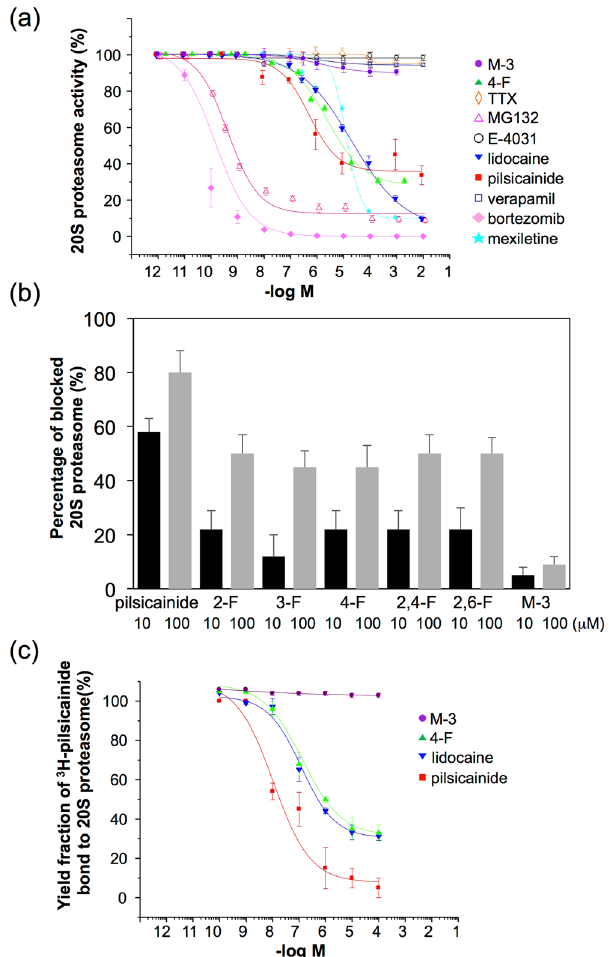
E-4031; ◊ : TTX; ▲ : 4-F; ● : M-3) on 20S proteasome activity in vitro . Each point represents the mean ± SEM of more than 7 determinations. 20S proteasome activities were expressed relative to their values in the absence of drugs (100%). The calculated IC 50 values were 4.1 ± 2.4 nM, 1.1 ± 1.8 nM, 3.5 ± 1.5 μ M, 23 ± 0.2 μ M, 20 ± 2.5 μ M, 14 ± 6.3 μ M for MG132, bortezomib, pilsicainide, lidocaine, 4F, and mexiletine, respectively. ( b ) Inhibitory action of pilsicainide, 2-F, 3-F, 4-F, 2,4-F, 2,6-F and M-3 at 10 μ M (left) and 100 μ M (right)